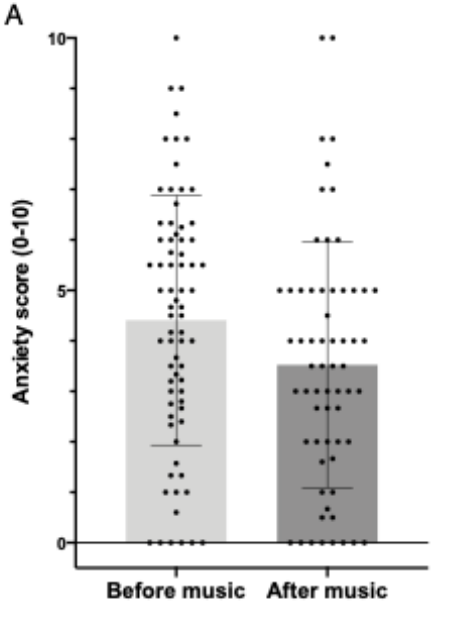
Figure 3. Effect of music on anxiety in emergency department patients. (A) Comparison of mean anxiety scores reported before and after the music listening intervention revealed a significant overall reduction in anxiety among individuals (related-samples Wilcoxon signed rank test, P <.001). The mean magnitude change in anxiety score with music was modest (mean difference –0.72, 95% CI –0.33 to –1.12) with considerable variability among participants. (B) Higher baseline anxiety scores were associated with a greater reduction in anxiety scores before and after the music session (Spearman ρ =0.3, P =.02).